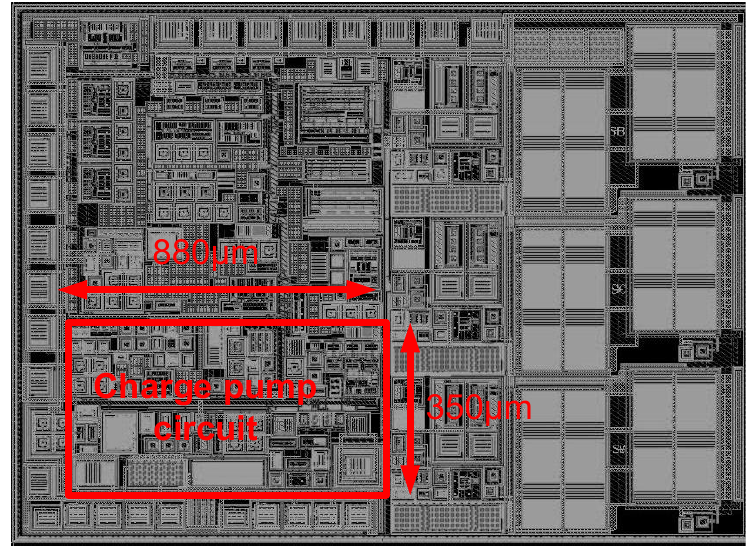
Figure 6. The layout of the charge